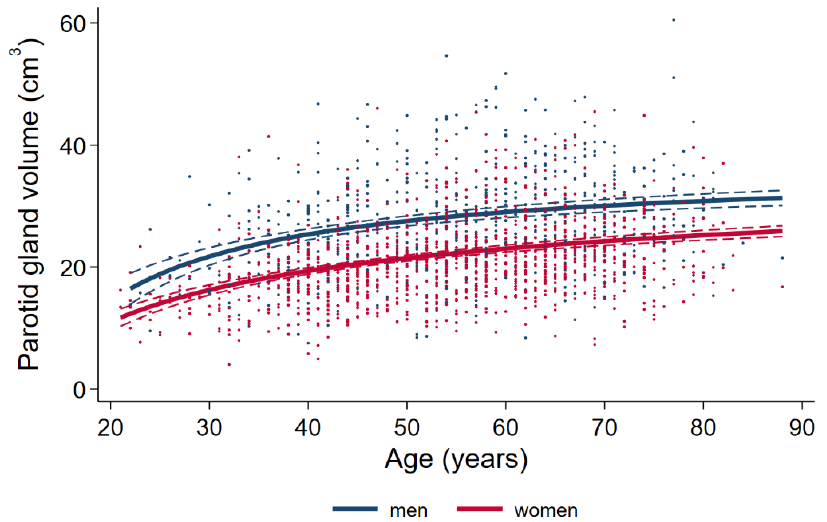
Figure 5. Association of sex and age with parotid gland volume differentiated by gender.